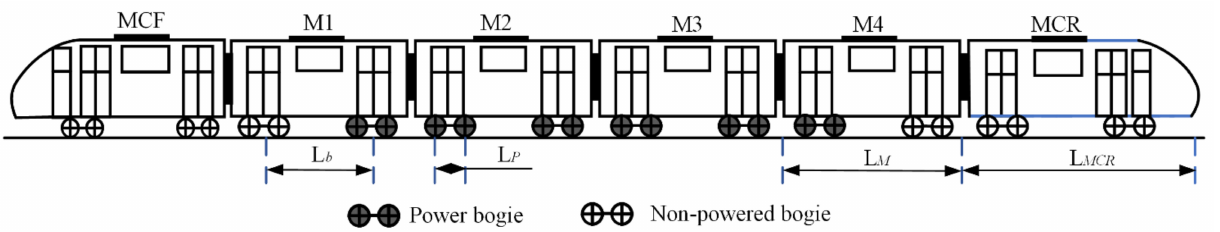
Figure 2. Schematic diagram of straddle-type monorail marshalling.